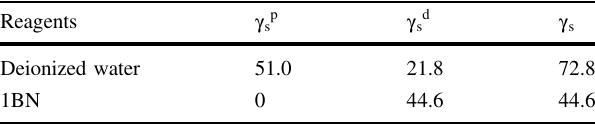
Table 1 Surface tension (r s ), polar and dispersive components (r sp , r sd ) of deionized water and 1BN Reagents γ